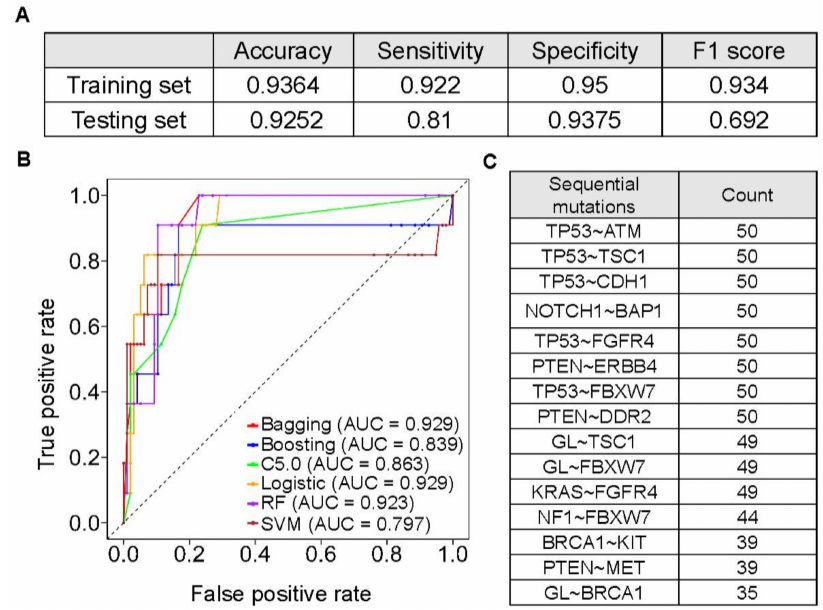
Figure 5. Hypermutated status prediction model. ( A ) A logistic regression model was used to predict hypermutations with the highest sensitivity. The table also shows the accuracy, specificity, and F1 scores for both the training ( n = 755, 80%) and testing ( n = 107, 20%) datasets. ( B ) Receiver operating characteristic (ROC) curves of six different classifiers and their area under the curve (AUC) values. Better sensitivity was achieved in the logistic regression model. RF, random forest; SVM, support vector machine. ( C ) Feature selection of hypermutation-associated sequential mutations. In total, fifteen sequential mutations were selected and are summarized in the